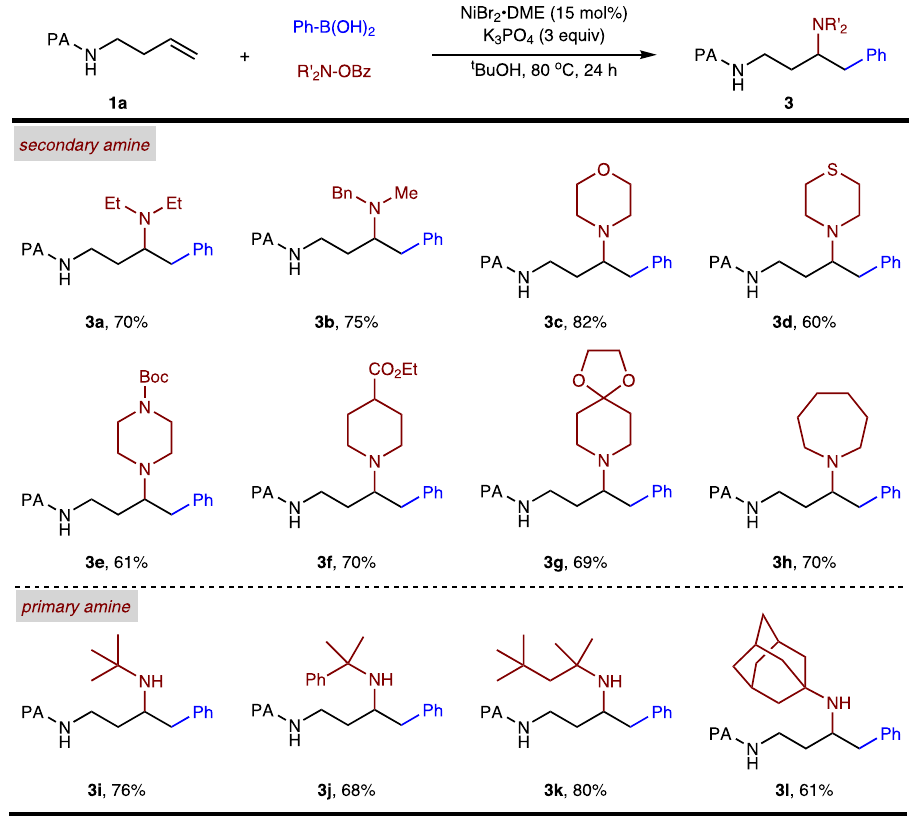
Fig. 4 Scope of amine electrophiles. Reactions conditions: 1a (0.2 mmol), PhB(OH) 2 (3 eq), N – O reagent (2 eq), t BuOH (2